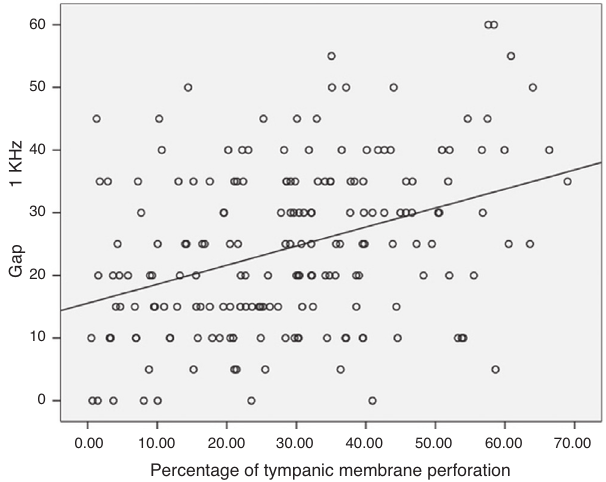
Figure 2 Correlation between percentage of tympanic mem- brane perforation and air-bone gap observed at a 500 Hz frequency.